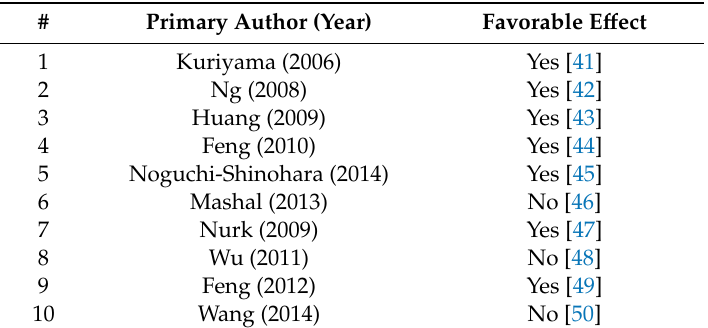
Table 1. Examples of observational studies on the e ff ect of (green) tea consumption on cognitive impairment. Edited after Pervin et al.